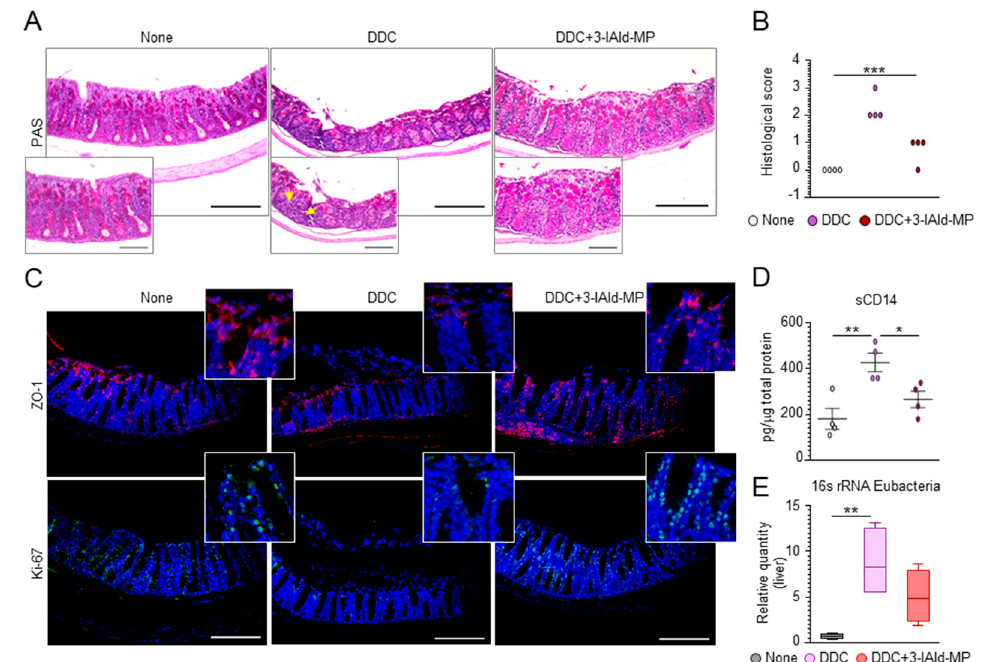
Figure 4. 3-IAld-MP prevents liver injury by reducing DDC-induced intestinal inflammation. C57BL/6 mice were fed for 14 days with a 0.1% DDC-containing diet and subjected to a recovery time of 14 days. The mice were treated intragastrically with 3-IAld-MP every other day throughout the experiment. The mice were evaluated for ( A ) colon histology by PAS staining, ( B ) histological score, ( C ) ZO-1 and Ki-67 immunofluorescence, ( D ) sCD14 release in serum, and ( E ) Eubacteria expression in the liver by RT-PCR. Photographs were taken with a high-resolution microscope (Olympus BX51), 20 × magnification (scale bars, 200 µ m). Yellow arrows indicate inflammatory cells. Hoechst was used for counterstaining nuclei. The data are presented as the mean ± SEM and are representative of three experiments ( n = 4 mice/group). * p < 0.05, ** p < 0.01, *** p < 0.001, treated vs. untreated (none) mice, and DDC vs. DDC + 3-IAld. One-way ANOVA, Bonferroni post-test, ( B ) Kruskal–Wallis test.